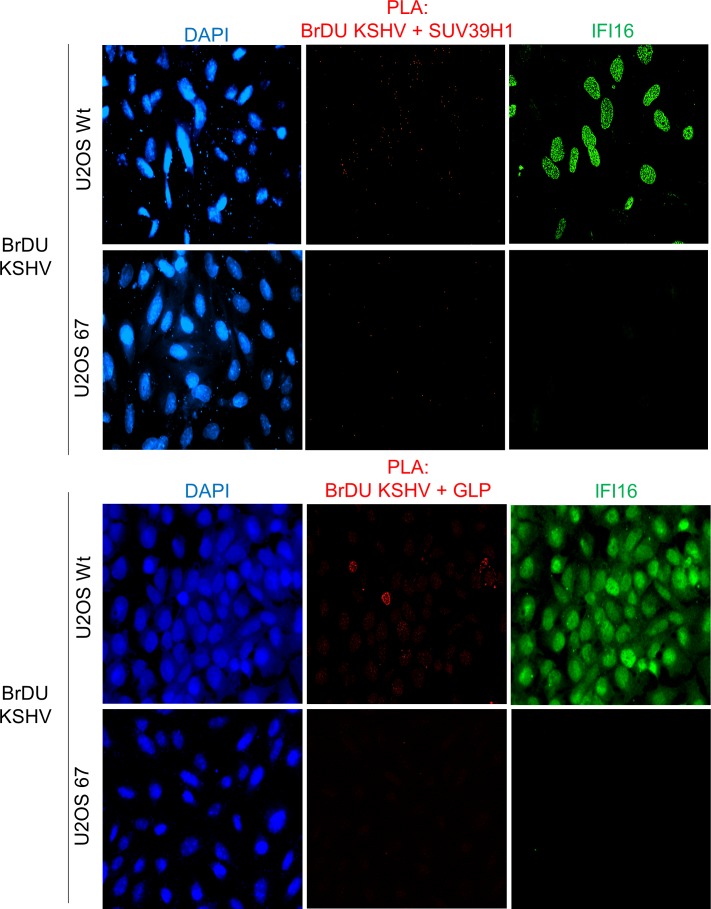
Uncropped source PLA data for Figure 6C and D.A larger field containing multiple cells are shown.